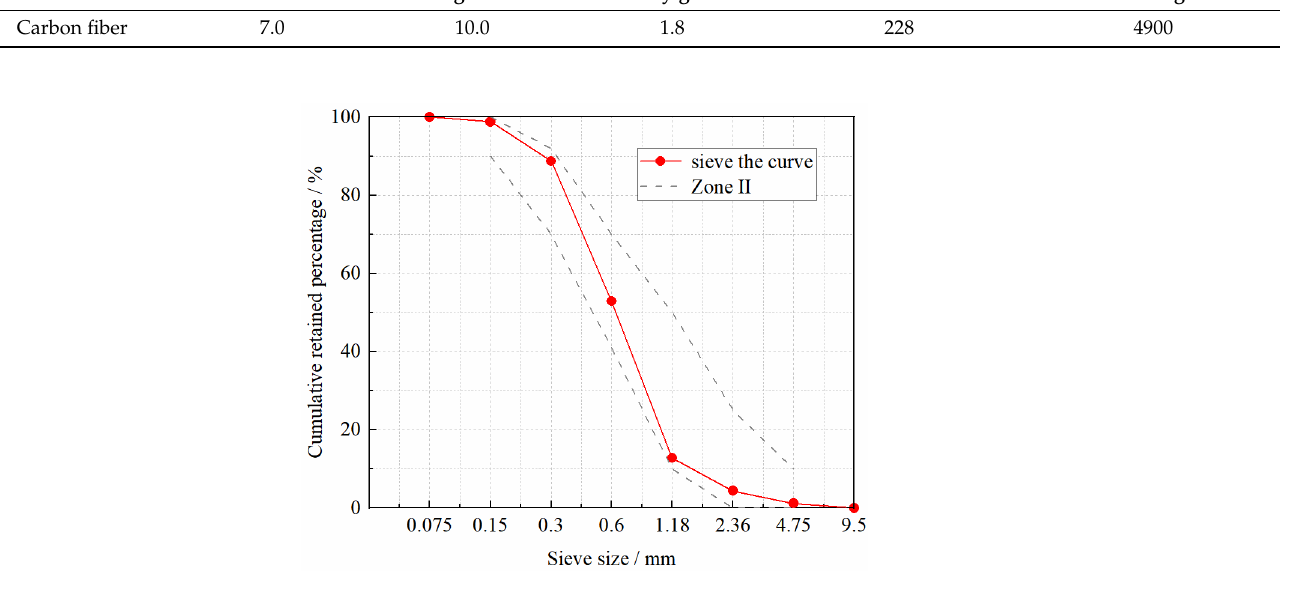
Figure 1. Sieve the curve for sand grading zones. Table 4. Mixture proportions for the test.